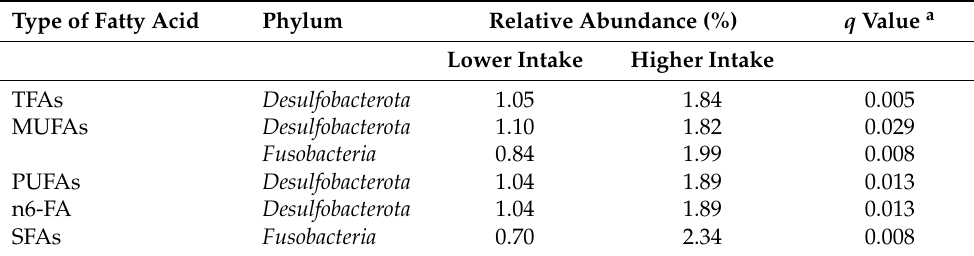
Table 2. Relative abundance of bacterial phylum by fatty acid